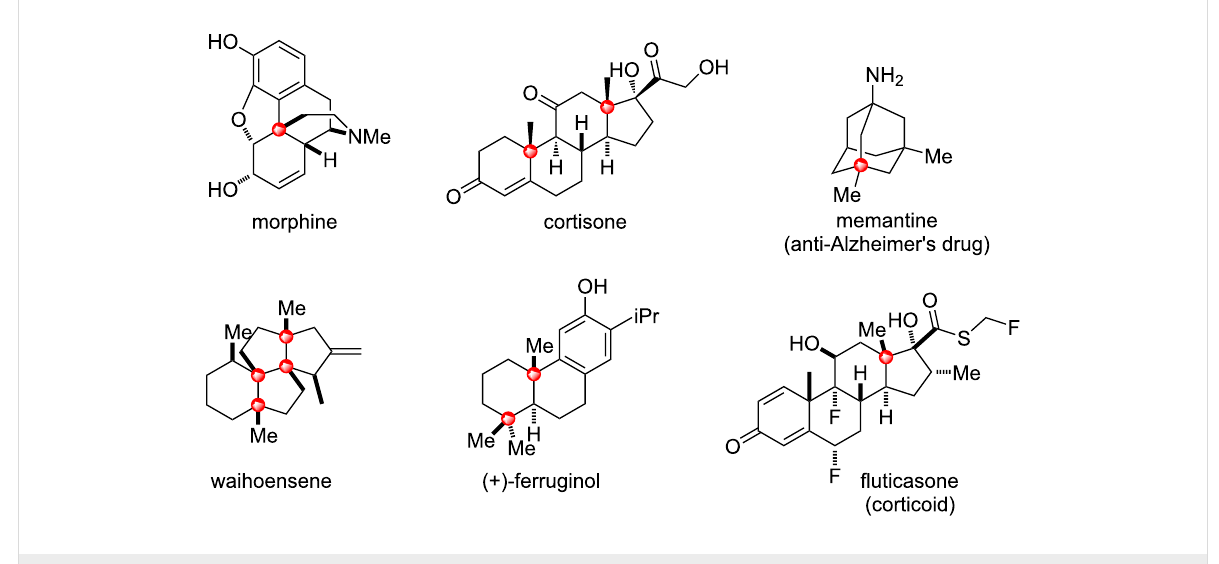
Figure 1: Some examples of natural products and drugs containing quaternary carbon centers.